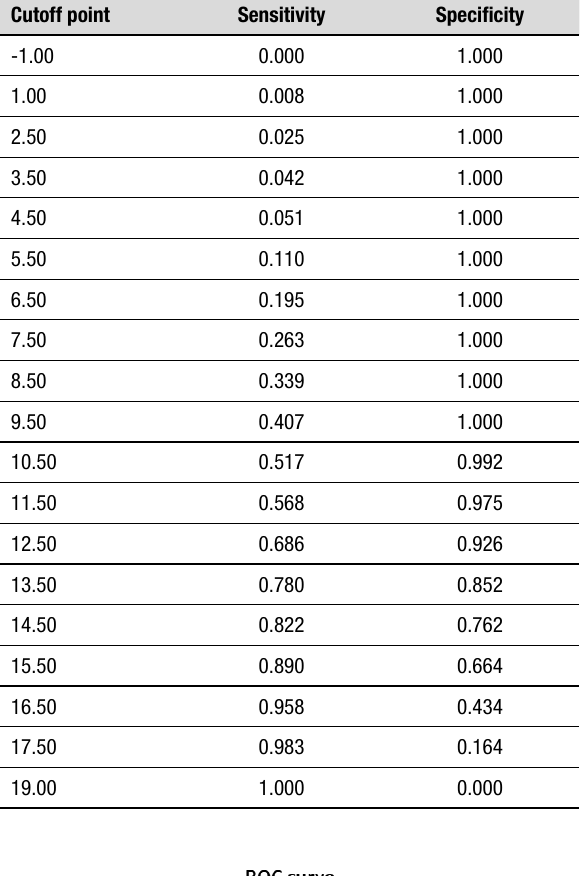
Table 4. Sensitivity and specificity of the Chilean version of the Frontal Assessment Battery on healthy controls (n=122) and patients (n=128) matched by age and education level.